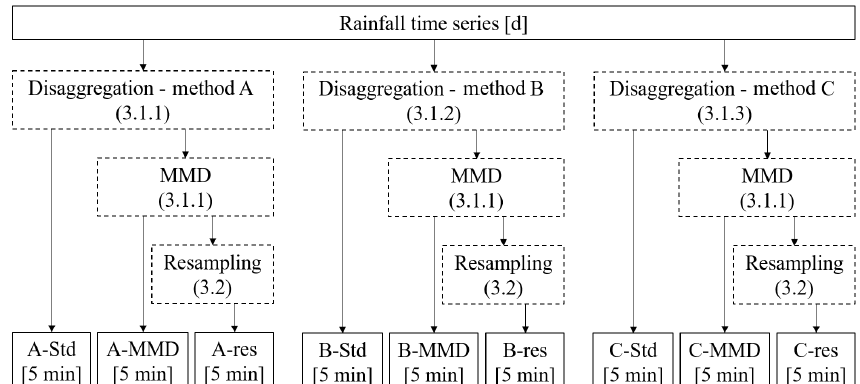
Figure 2. Overview of applied methods (dashed rectangles) and the resulting data sets (bottom line). In the brackets behind the applied methods the subsection with the method description is referenced. Std refers to “standard” (no modification of the disaggregated time series), MMD is the “mimicry of the measurement device” to avoid too small rainfall intensities, and res refers to “resampled” time series.